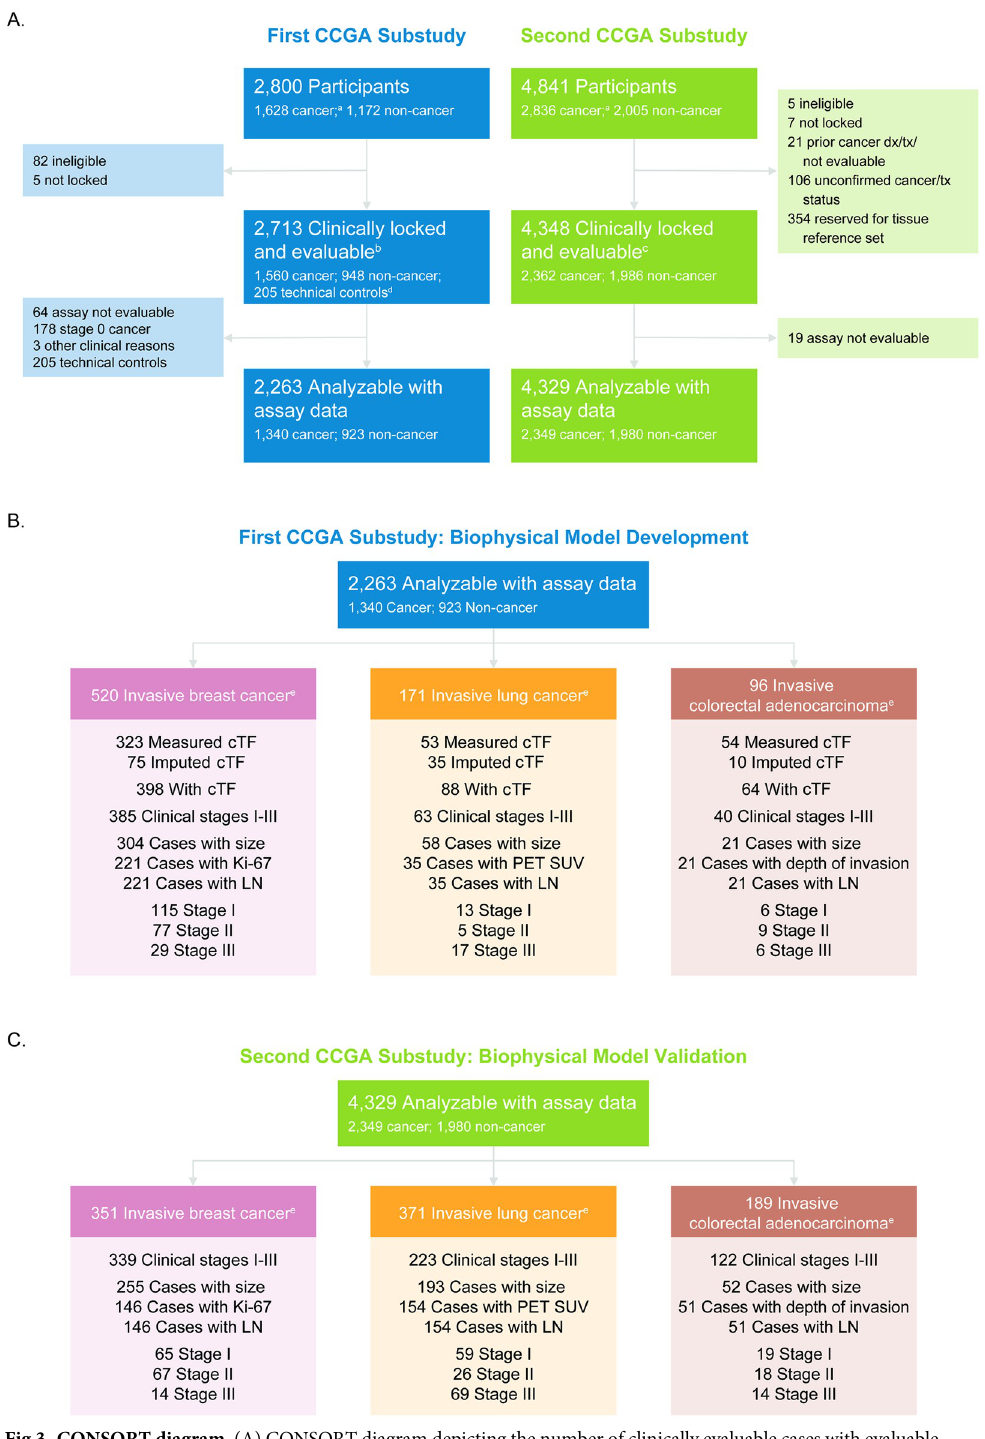
Fig 3. CONSORT diagram. (A) CONSORT diagram depicting the number of clinically evaluable cases with evaluable assay results for model generation from the first CCGA substudy (left) and model validation from the second CCGA substudy (right). (B) Cases available for model development from the first CCGA substudy and (C) cases available for model validation from the second CCGA substudy for breast (left), lung (center), and colorectal cancers (right). Cases were filtered by availability of clinical data (size of primary tumor, Ki-67 for breast cancer, PET SUV for lung cancer, depth of microinvasion for colorectal cancer, respectively, and presence of tumor-involved lymph nodes) for modeling and available